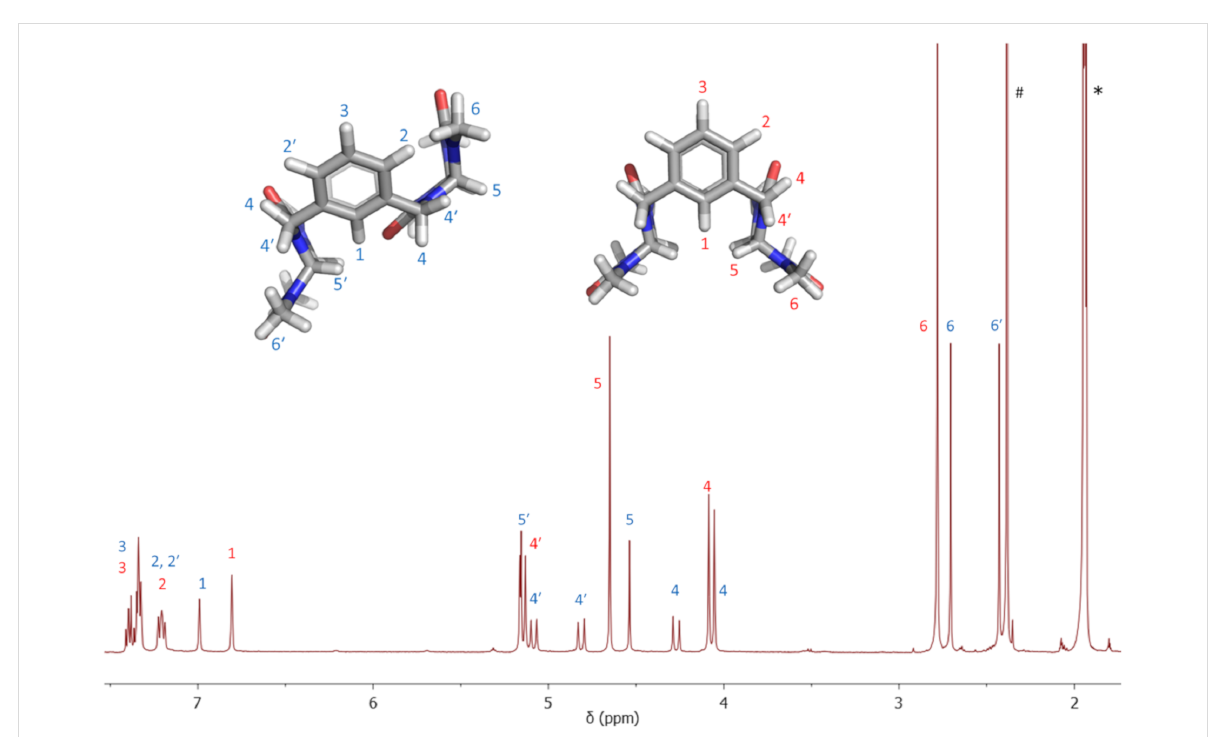
Figure 3: 1 H NMR spectrum of 1a in MeCN- d 3 measured at − 40 °C. # Signal of water. *Signal of acetonitrile.